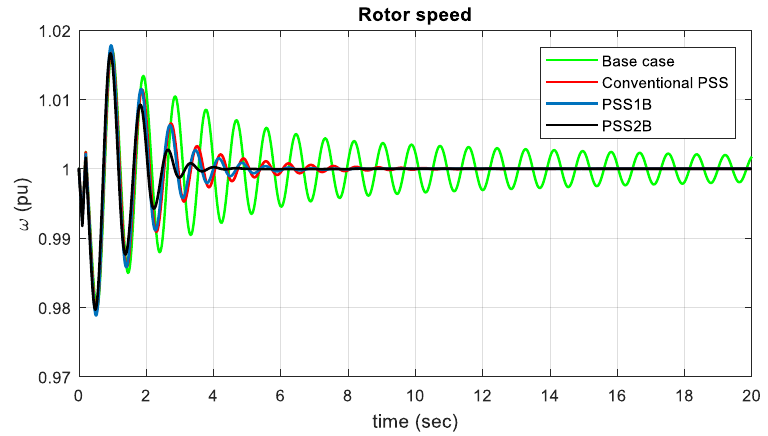
Figure 24. Rotor speed of power system at light loading.